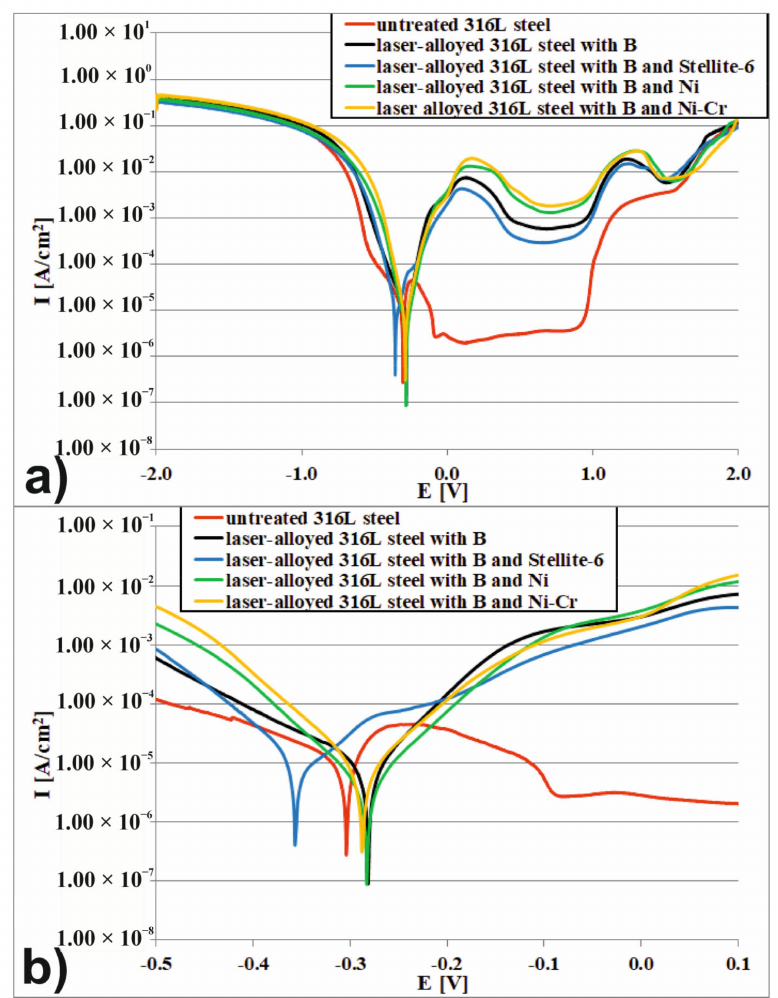
Figure 15. Polarization curves obtained in 1 M H 2 SO 4 corrosion medium by the potentiodynamic method for laser-alloyed layers with boron and selected metallic elements produced on 316L steel using a laser beam power of 1.43 kW compared to laser-alloyed steel with only boron with a dilution ratio of 0.54 and 316L steel without treatment. Potential range from − 2 to 2 V, potential change rate 0.5 mV/s. The entire polarization curves ( a ) and magnification of the area in which corrosion potential and corrosion current density were determined ( b